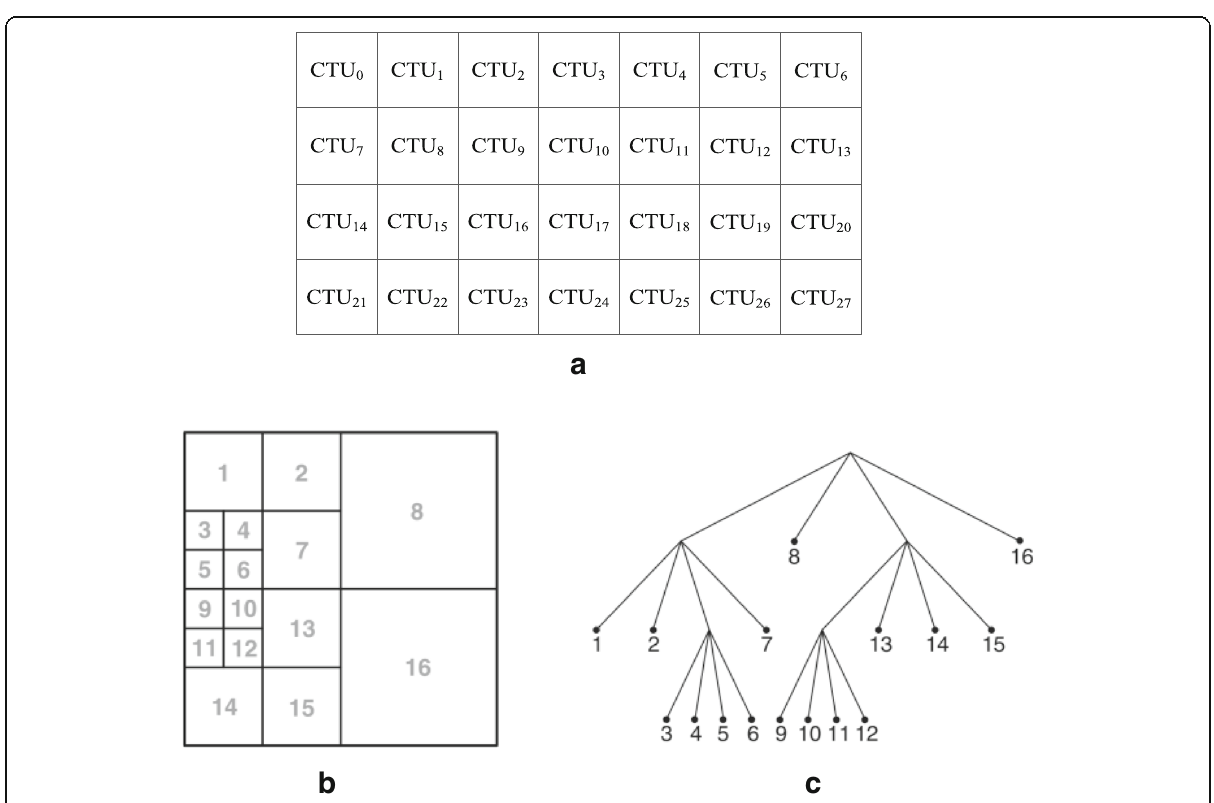
Fig. 1 Examples of the partitioning of a picture into CTUs ( a ) and the partitioning of a 64 × 64 coding tree unit (CTU) into coding units (CUs) ( b ). The partitioning can be illustrated by a quadtree ( c ), where the numbers indicates the coding order of